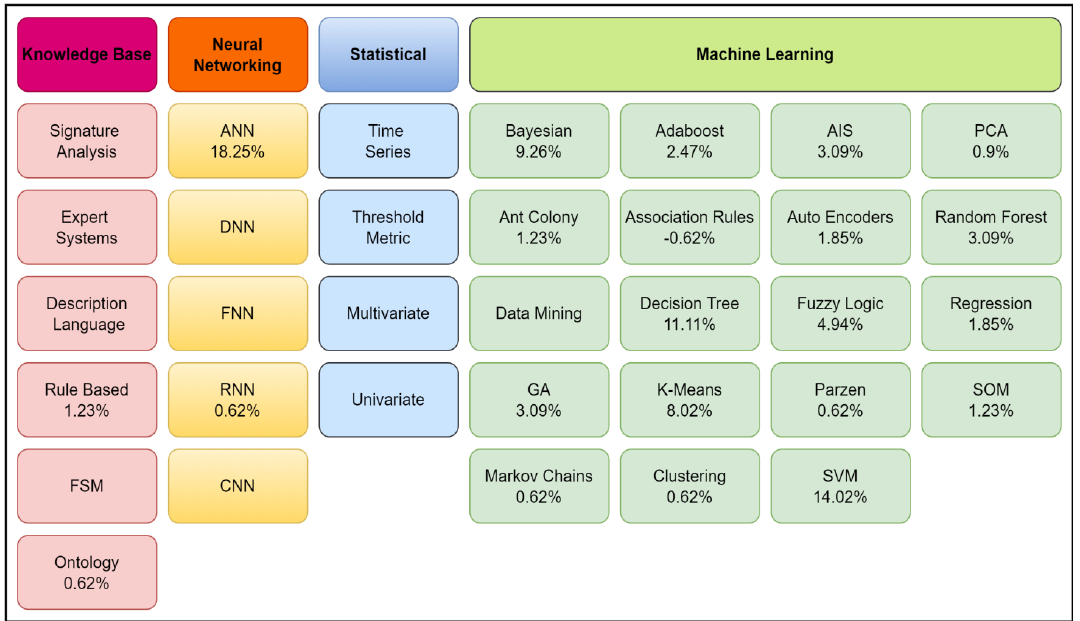
Figure 1. Algorithm distribution.